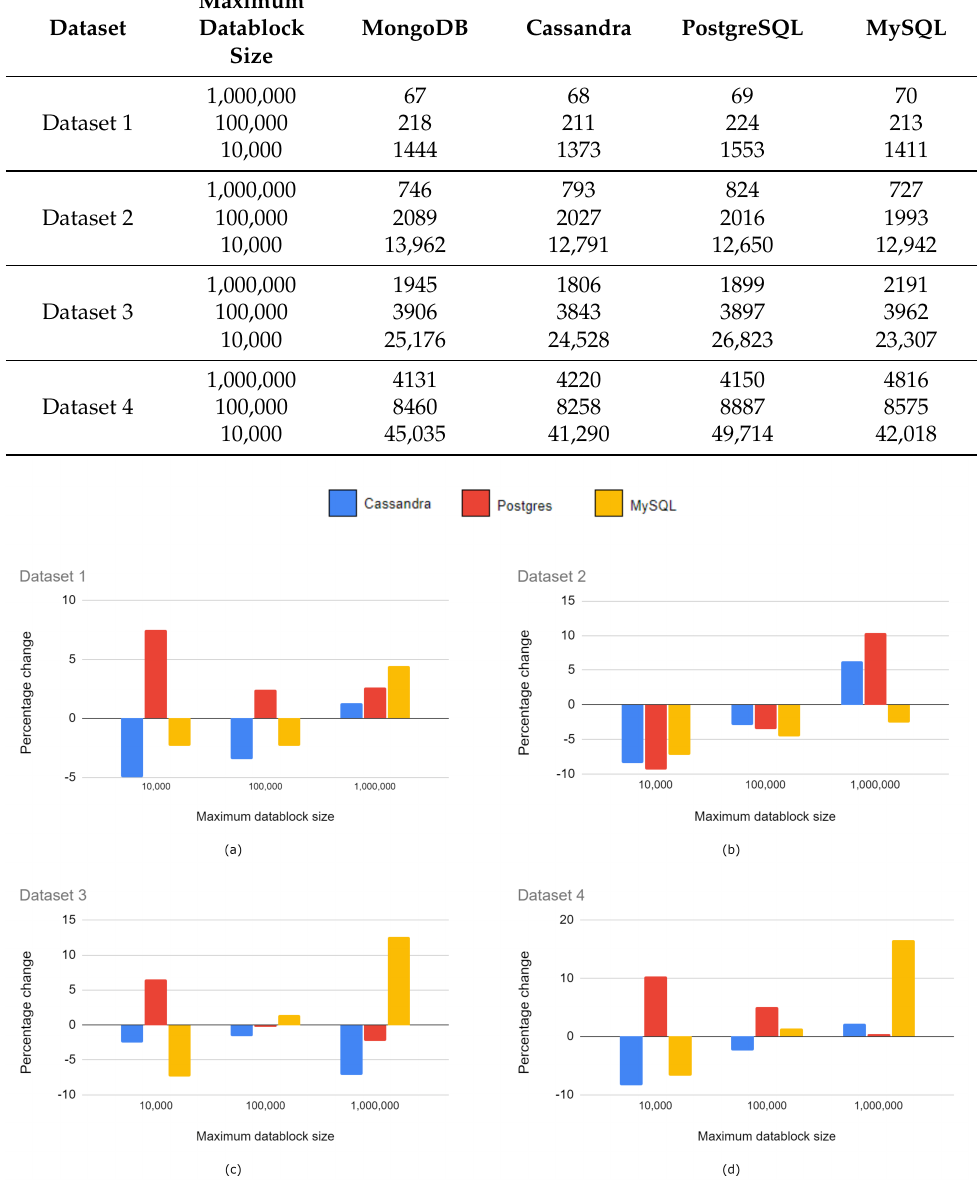
Figure 6. Relative comparison of upload times. Results for ( a ) Dataset 1; ( b ) Dataset 2; ( c ) Dataset 3; and ( d ) Dataset